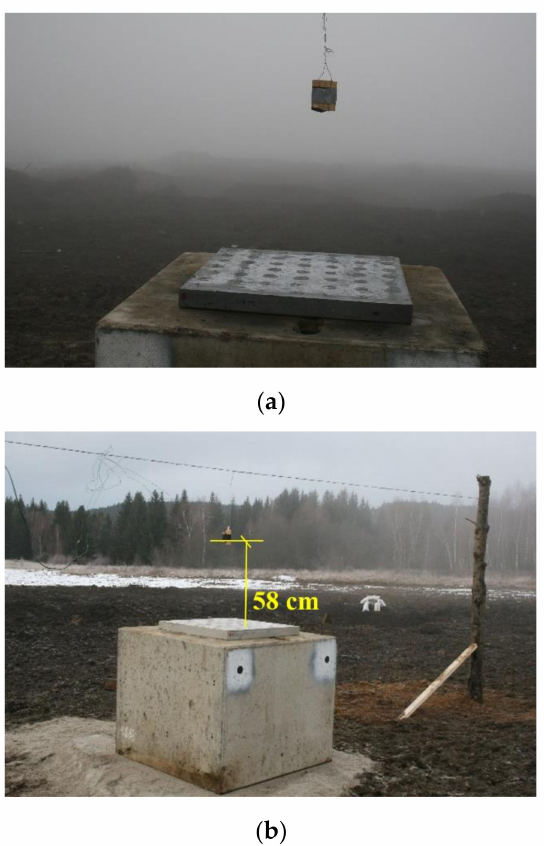
Figure 5. Experiment setup: ( a ) Stand with suspended explosive of 600 g TNT; ( b ) Stand with suspended explosive of 275 g TNT, 58 cm above the